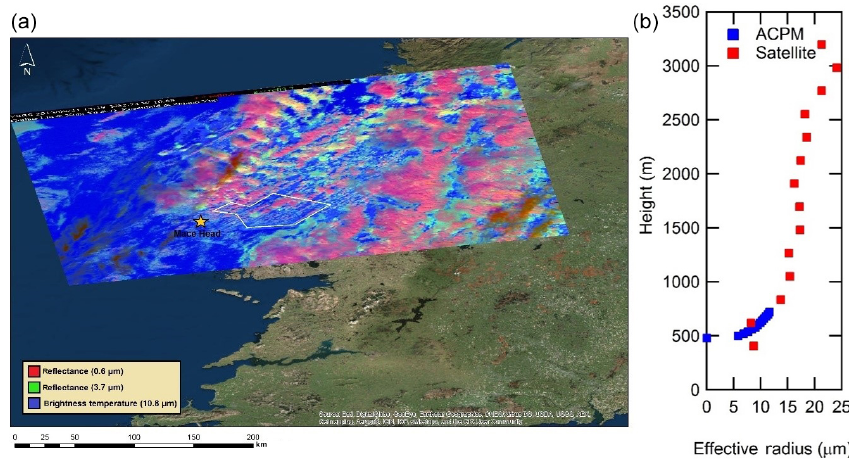
Figure 4. Suomi NPP satellite RGB composite image for 21 August 2015 (a) . Mace Head Atmospheric Research Station and UAV flight location are indicated by the yellow star. The white polygon represents the zone for retrieving cloud properties – which is represented by the profile of cloud effective radius (b) . Effective radius profiles are presented for both the Suomi NPP satellite (red) and the ACPM